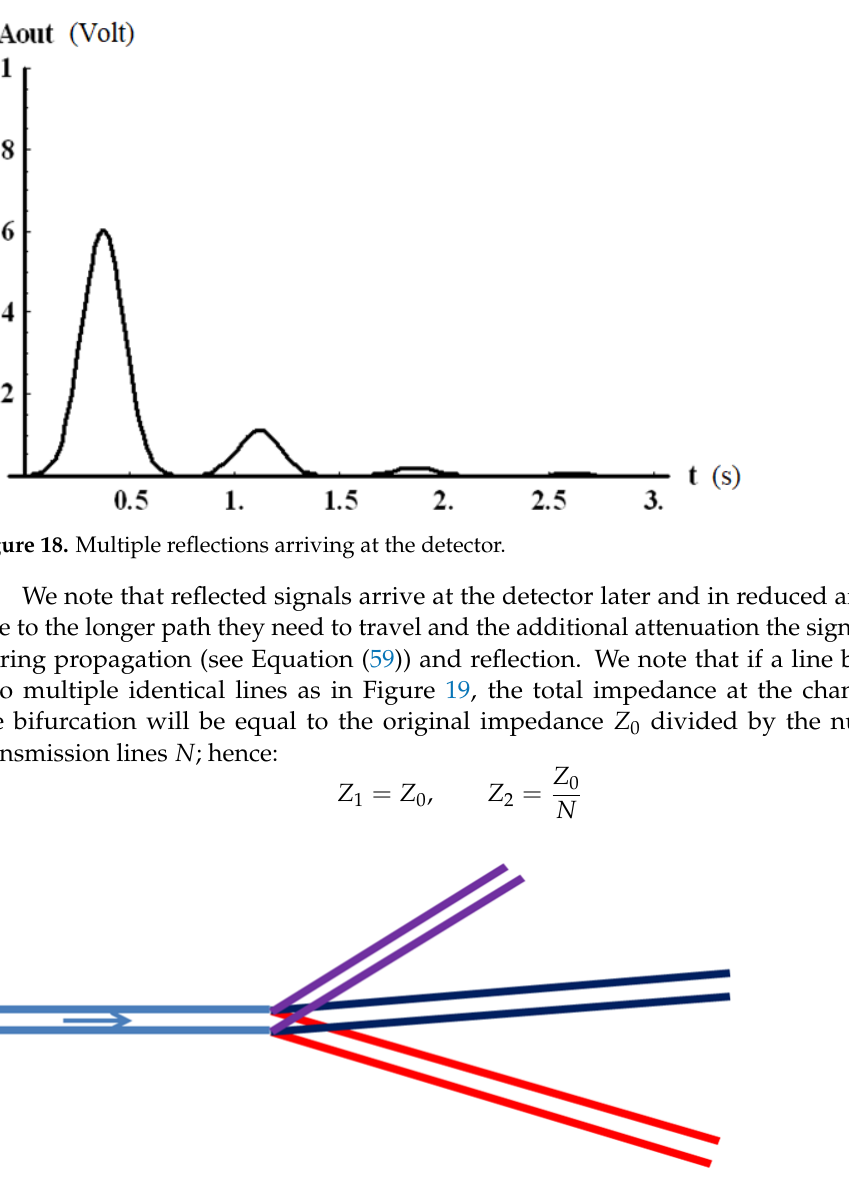
Figure 19. A transmission line bifurcating into multiple